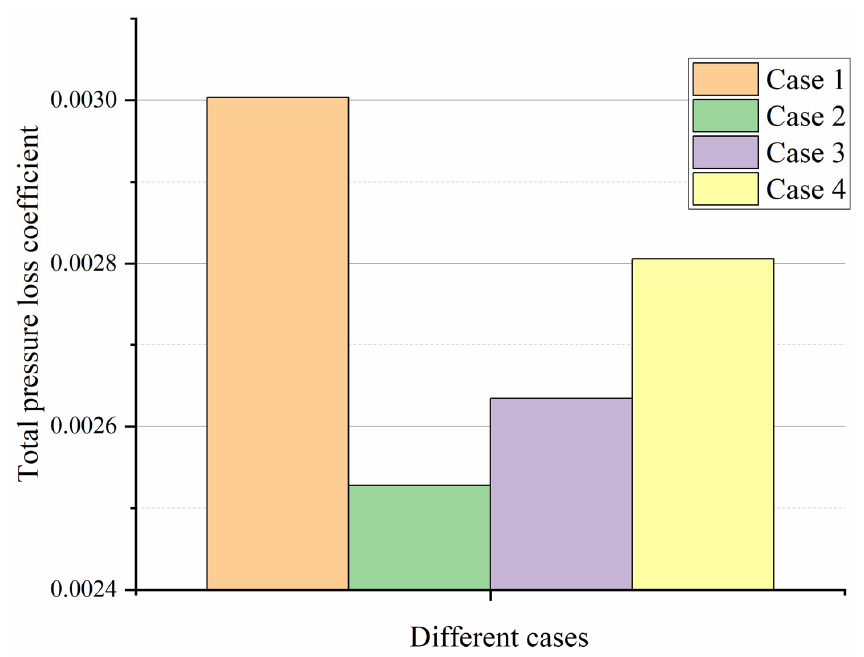
Figure 9. Time-averaged non-dimensional velocity distributions calculated from LES for di ff erent cooling holes in the center of the section plane.